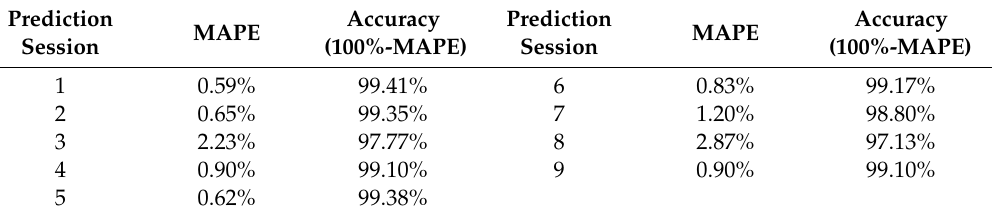
Table 4. Accuracy